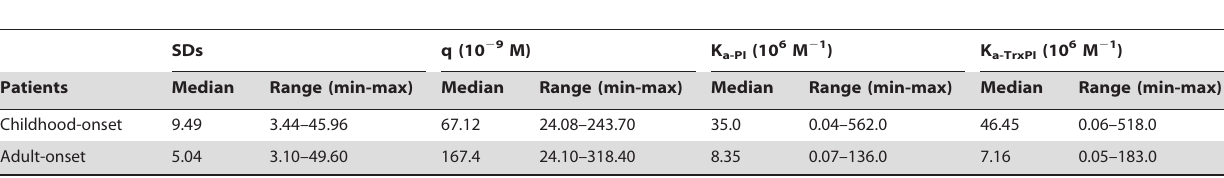
Table 1. Comparison of antigen-antibody interaction parameters: Standard Deviation Score (SDs) of signals obtained by RBA; antibody concentration (q) and affinity (K a ) calculated by BIAevaluation software analysis (BIAcore TM